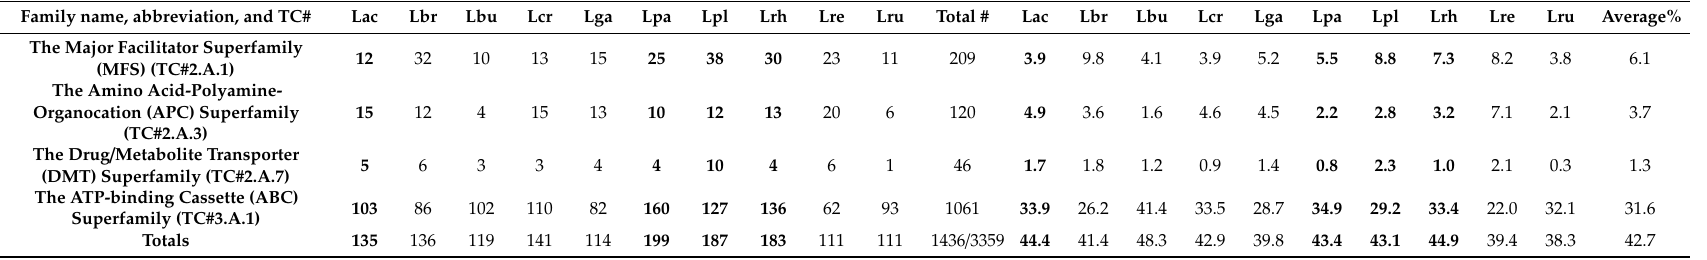
Table 5. Tabulation of the four largest transport protein families encoded within the genomes of the ten Lactobacillus strains. Both the total number of proteins (left) and average percentages of major family members (right) are shown. PAP strains are marked in